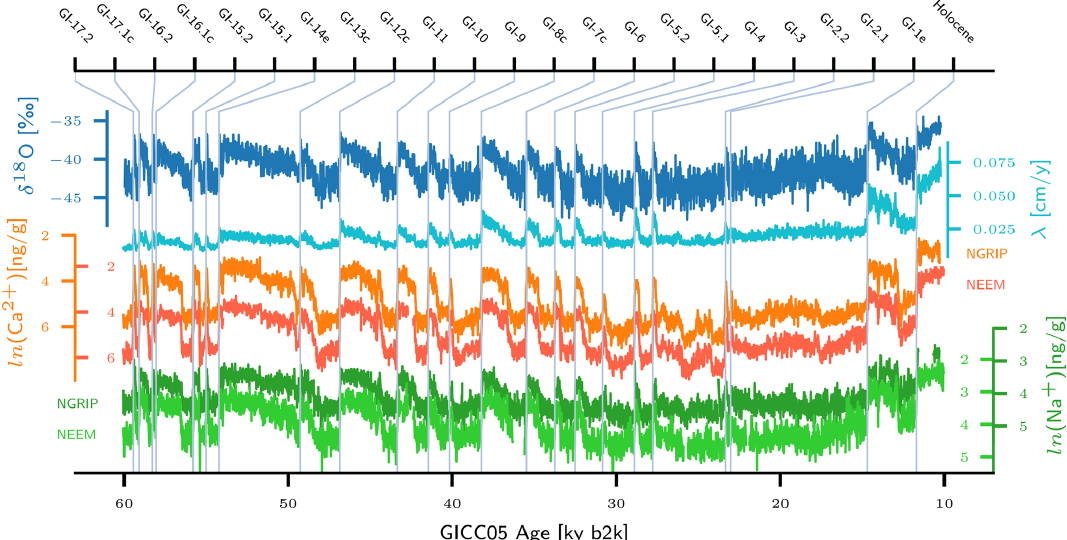
Figure 1. Time series of δ 18 O (blue), annual layer thickness λ (cyan), Ca 2 + (orange), and Na + (green) from the NGRIP ice core, together with time series of Ca 2 + (red) and Na + (light green) from the NEEM ice core on the GICC05 timescale in kyb2k, at 10-year resolution. Light blue vertical lines mark the timings of major DO events. All time series are retrieved from Erhardt et al. (2019), and for the DO event timings and Greenland interstadial (GI) notation we followed Rasmussen et al. (2014). Originally, the δ 18 O record was published by NGRIP project members (2004) as 50-year mean values and later at higher resolution (5cm) as a Supplement to Gkinis et al. (2014). The GICC05 age scale for the NGRIP ice core was compiled by Vinther et al. (2006), Rasmussen et al. (2006), Andersen et al. (2006), and Svensson et al. (2008). For the NEEM ice core, the GICC05 presented by Rasmussen et al. (2013) is used